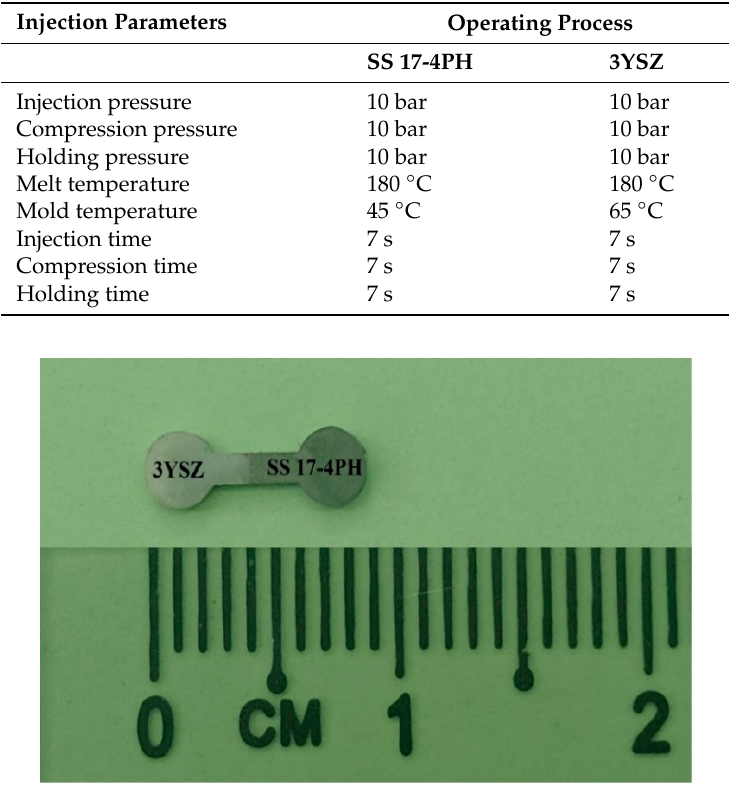
Metals 2020 , 10 , x FOR PEER REVIEW Figure 10. Bi-material micro-part of SS 17-4PH and 3YSZ materials. Figure 10. Bi-material micro-part of SS 17-4PH and 3YSZ materials.